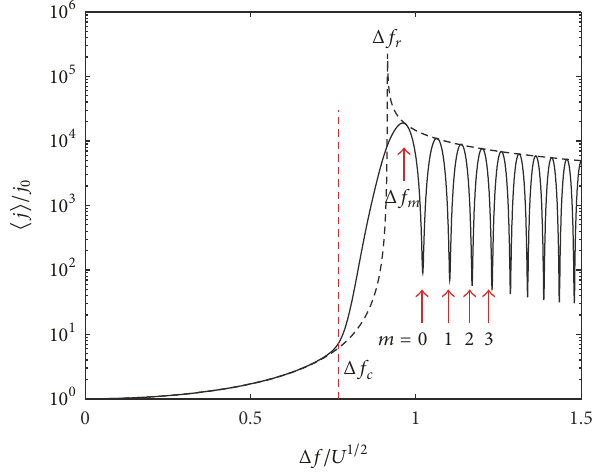
= 2𝐾 − 𝑓 ≅ 0.3944 , 𝑟 0